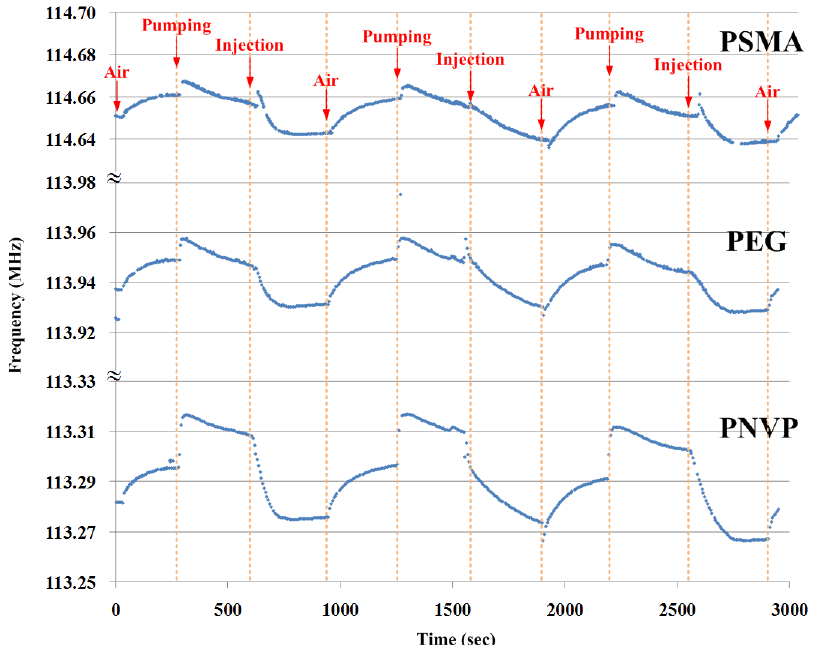
Figure 8. Typical sensor response (gas: ethanol, membrane: PNVP).